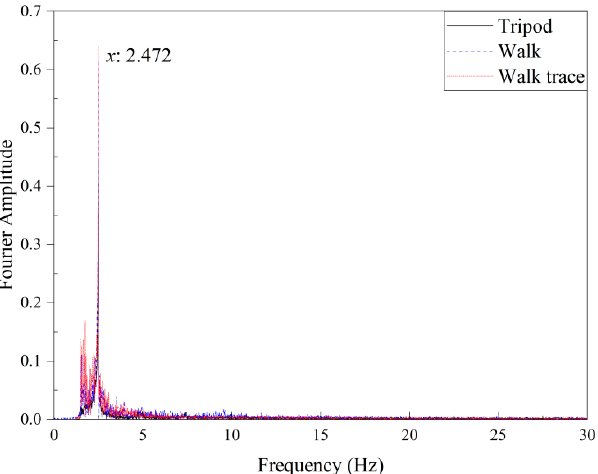
Figure 17. Frequency domain comparison of monitoring under three common smartphone shooting